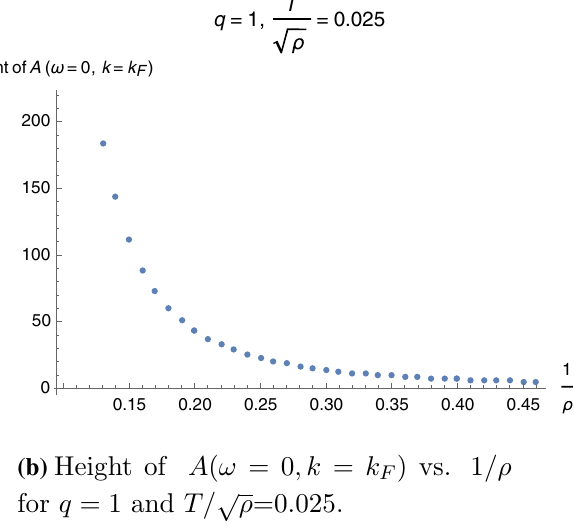
√ √ ρ vs. ρ/k q = 2. (b) T/ ( a ) T/ p plane for √ √ ρ/ k ρ vs. and gradually increase with the lighter shade. The green and yellow Fig. 5 Density plot of ν in T / p plane. The colour gradi- dashed lines correspond to ν = 1 / 2 and ν = 1 respectively ent corresponds to the value of ν which increases from left to right. The white portion is the oscillatory region with darkest shades being ν = 0